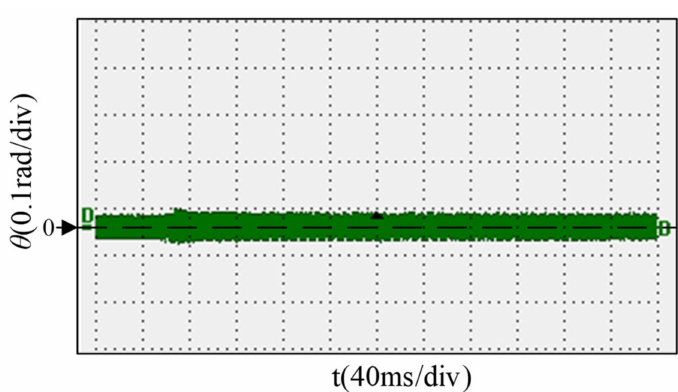
Figure 29. Rotor position waveforms at the sudden change of rotation speed.